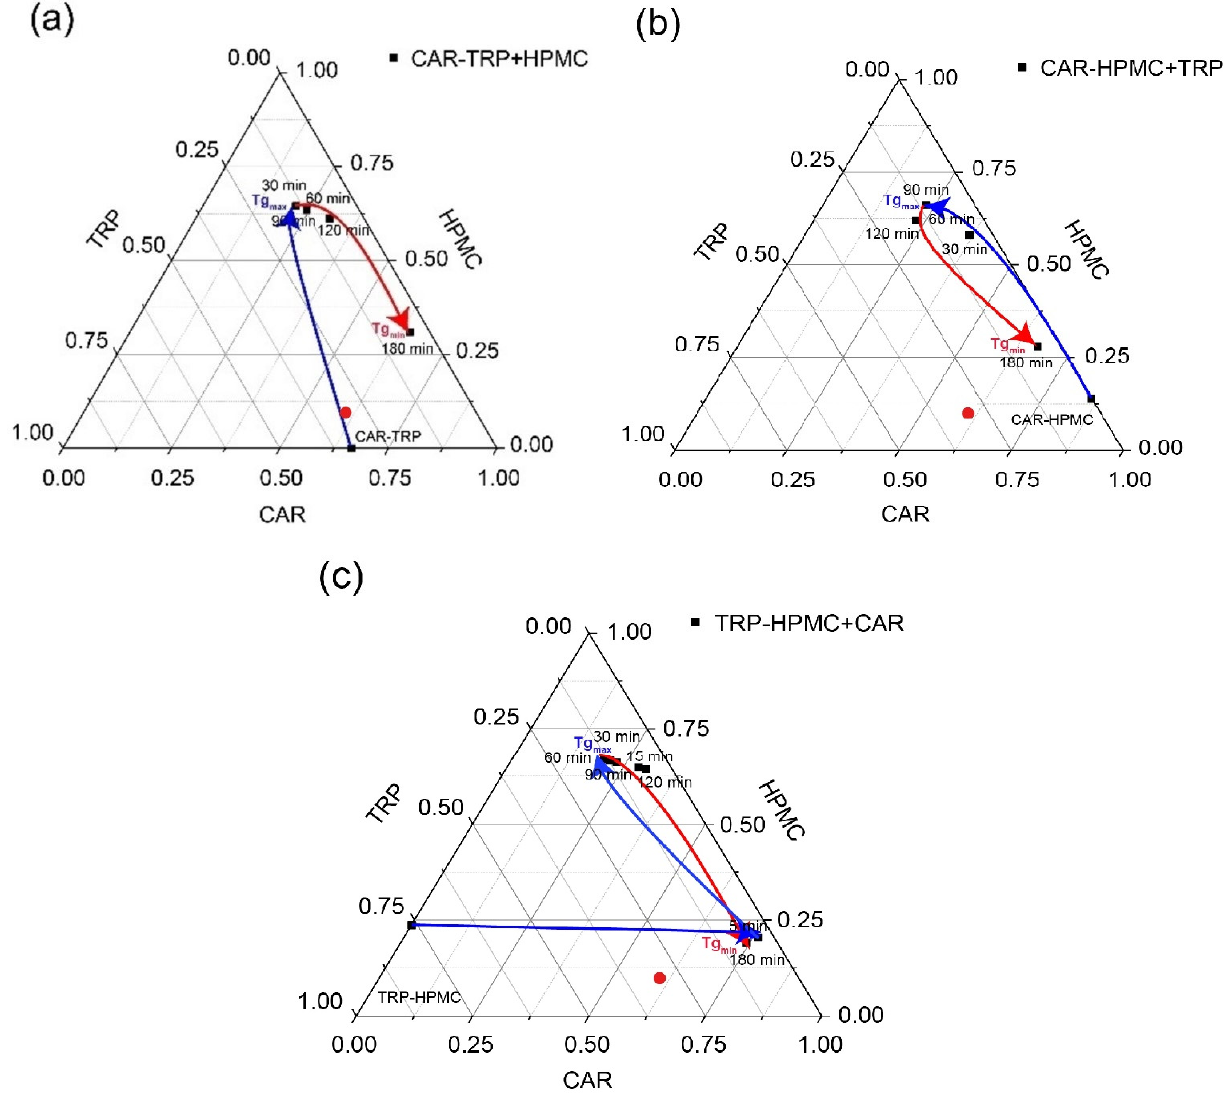
Figure 6. Ternary phase diagrams of CAR − TRP + HPMC ( a ), CAR − HPMC + TRP ( b ) and TRP − HPMC + CAR ( c ) A-B+C amorphous systems. The arrows indicate the change in the composition ratio of the saturated amorphous A − B + C ternary phase during the rise and fall of the T g values upon milling. The positions of the maximum and minimum of the T g s in each ternary phase diagram are marked by T g max and T g min. The theoretical composition without phase separaion is indicated with a red dot (CAR:TRP:HPMC = 60.5%:30.4%:9.1%).